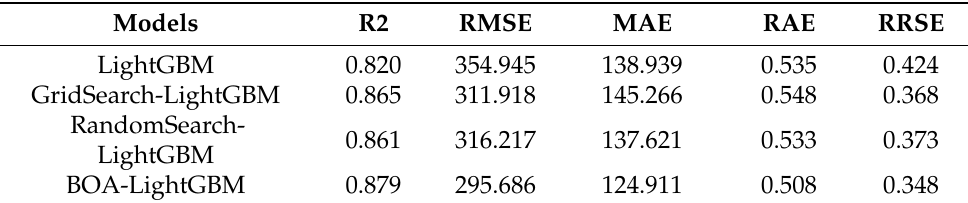
Table 5. Model evaluation